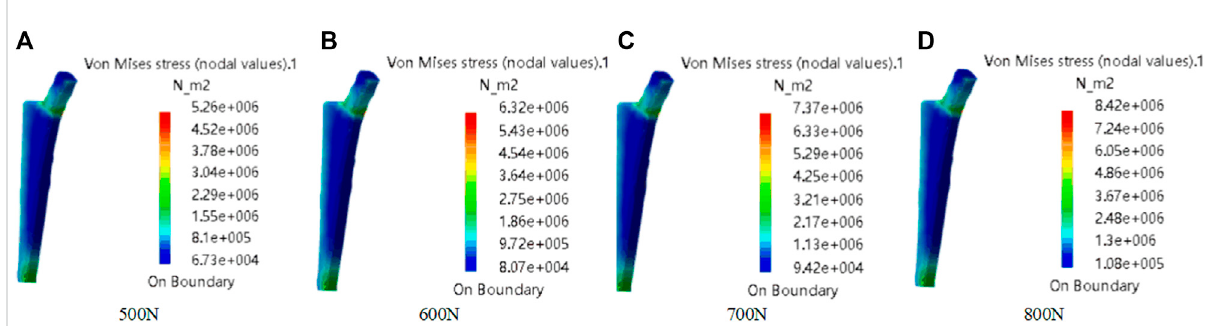
FIGURE 17 Mechanical property of femoral stem prosthesis. The distributed force was applied to the proximal end of model. From (A – D) , the force values are 500N, 600N, 700N, and